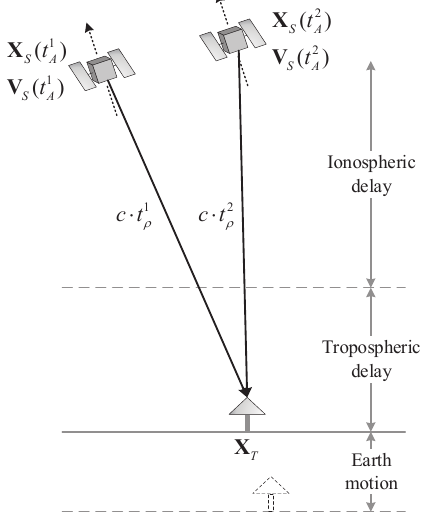
Figure 1. The typical geometry of SAR absolute